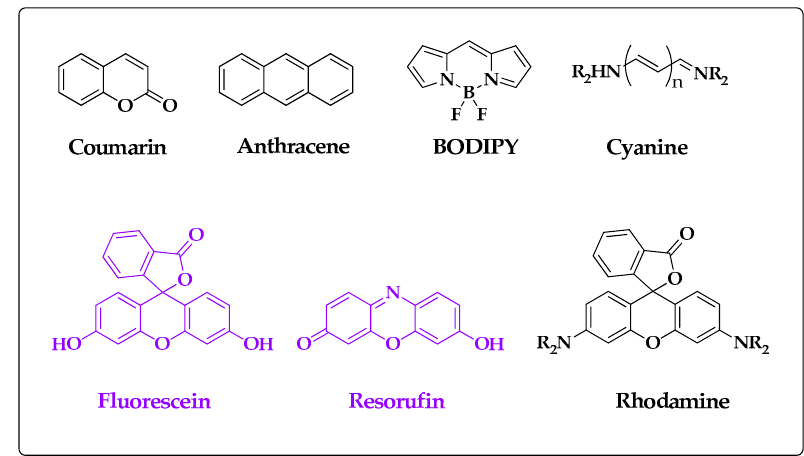
Figure 3. Frequently used dyes for probe synthesis and bioimaging of H 2 O 2 in biological systems such as cells or extracellular fluids. The purple color highlights pH sensitive dyes. as cells or extracellular fluids. The purple color highlights pH sensitive